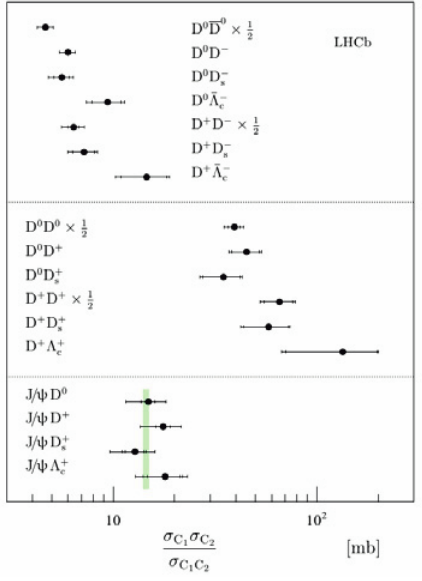
σ /σ Figure 17. Measured ratios σ C C 2 C 1 C 2 (points with error bars) in comparison with the expectations from 1 DPS using the cross-section measured at Tevatron for multi-jet events (light green shaded area). For the D 0 D 0 , D 0 ¯ D 0 , D + D + and D + D − cases the ratios are rescaled with the symmetry factor of one half. The inner error bars indicate the statistical uncertainty whilst the outer error bars indicate the sum of the statistical and systematic uncertainties in quadrature. For the J /ψ C case the outermost error bars correspond to the total uncertainties including the uncertainties due to the unknown polarization of the prompt J /ψ mesons.